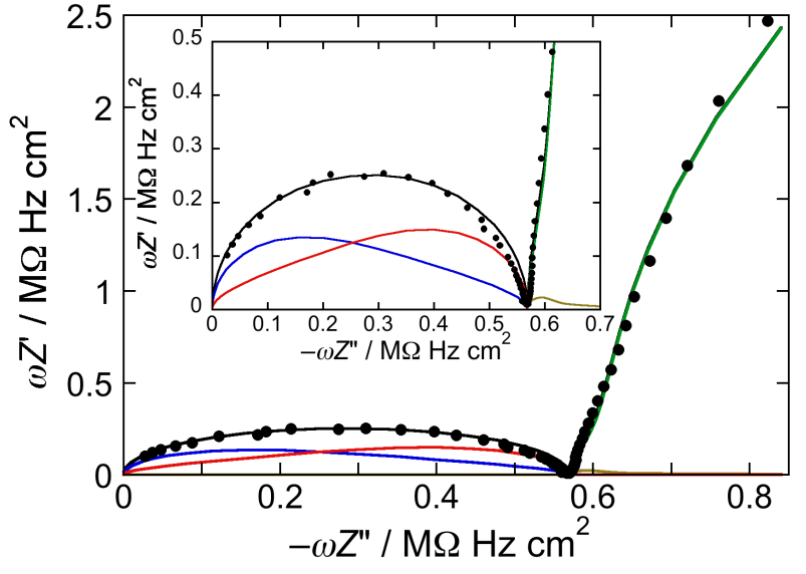
Figure 2. Plot of ω Z ′ against −ω Z ″ for a Hg-supported DOPC/Chol/PSM (59:26:15) mol% monolayer in aqueous 0.1 M KCl at − 0.550 V. Solid circles are experimental points and the black curve is the best fit to these points by a series of four RC meshes. The contributions to ω Z ′ against −ω Z ″ are represented in blue for the hydrocarbon tails, in red for the polar heads, in brown for the diffuse layer, and in green for the aqueous solution. Capacitances and = 0.13 M Ω ·cm 2 , C = 3.7 µF·cm − 2 , R = 50 k Ω ·cm 2 , resistances of the four RC meshes are: R ht ht ph C = 3.3 µF·cm − 2 , R = 0.9 Ω ·cm 2 , C = 50 µF·cm − 2 , R = 3.8 Ω ·cm 2 , C = 38 nF·cm − 2 . The ph dl dl Ω Ω impedance spectrum in the inset covers a narrower frequency